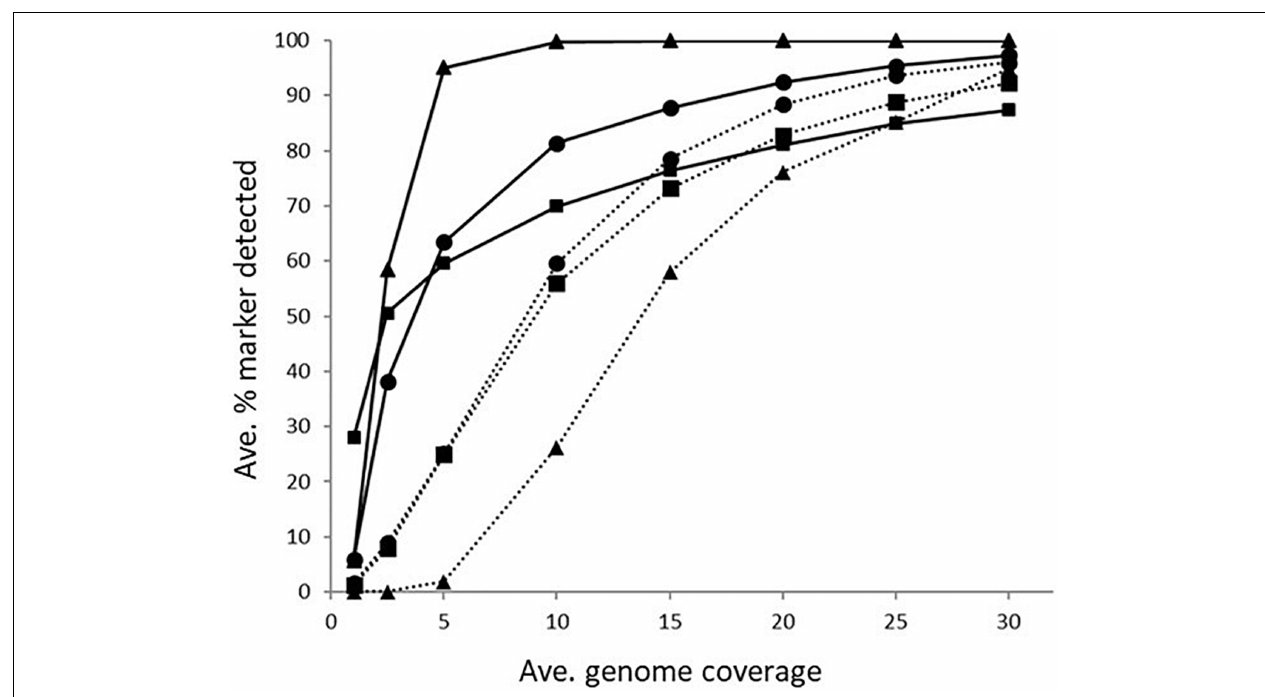
FIGURE 1 | The average percentage of subsampled reads in which bla OXA gene (dotted line) and tet(O) gene (solid line) was detected in the WGS data at increasing raw read coverage levels. Data points represent the average proportion of subsamples in which a gene was observed that was also observed when each